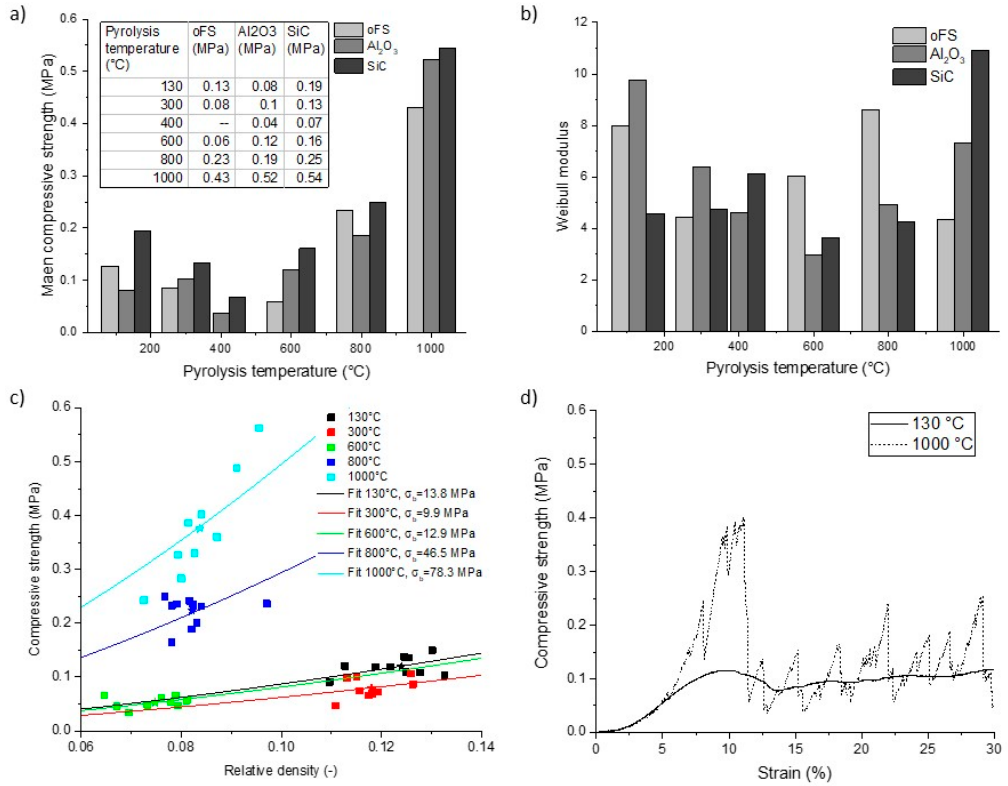
Figure 11. ( a ) Compressive strength of foams with fillers and of the filler-free foams as a function of the crosslinking / pyrolysis temperature. ( b ): Weibull modulus of the foams pyrolyzed at different temperatures. ( c ) Compressive strength of pyrolyzed foams against relative density including the fits according to Equation (3) with n = 3 / 2 and C = 0.2. The fitted bending strength σ b is given in the legend. (cid:70) indicates the corresponding median value for each sample series. ( d ) Typical stress-strain diagram of a filler-free and crosslinked foam, which still contains the polyurethane template and of a filler-free foam pyrolyzed at 1000 °C.